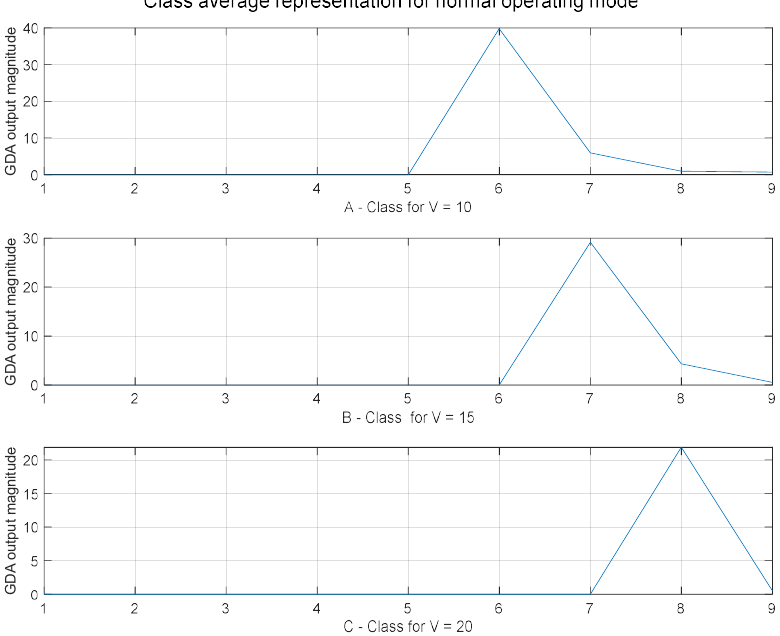
Figure 10. Classes average representation for V = 10 (A), V = 15 (B) and V = 20 (C). The next step is now to represent the bad positioning operating mode overlaid on Figure 10 which is considered as the reference for the next steps.